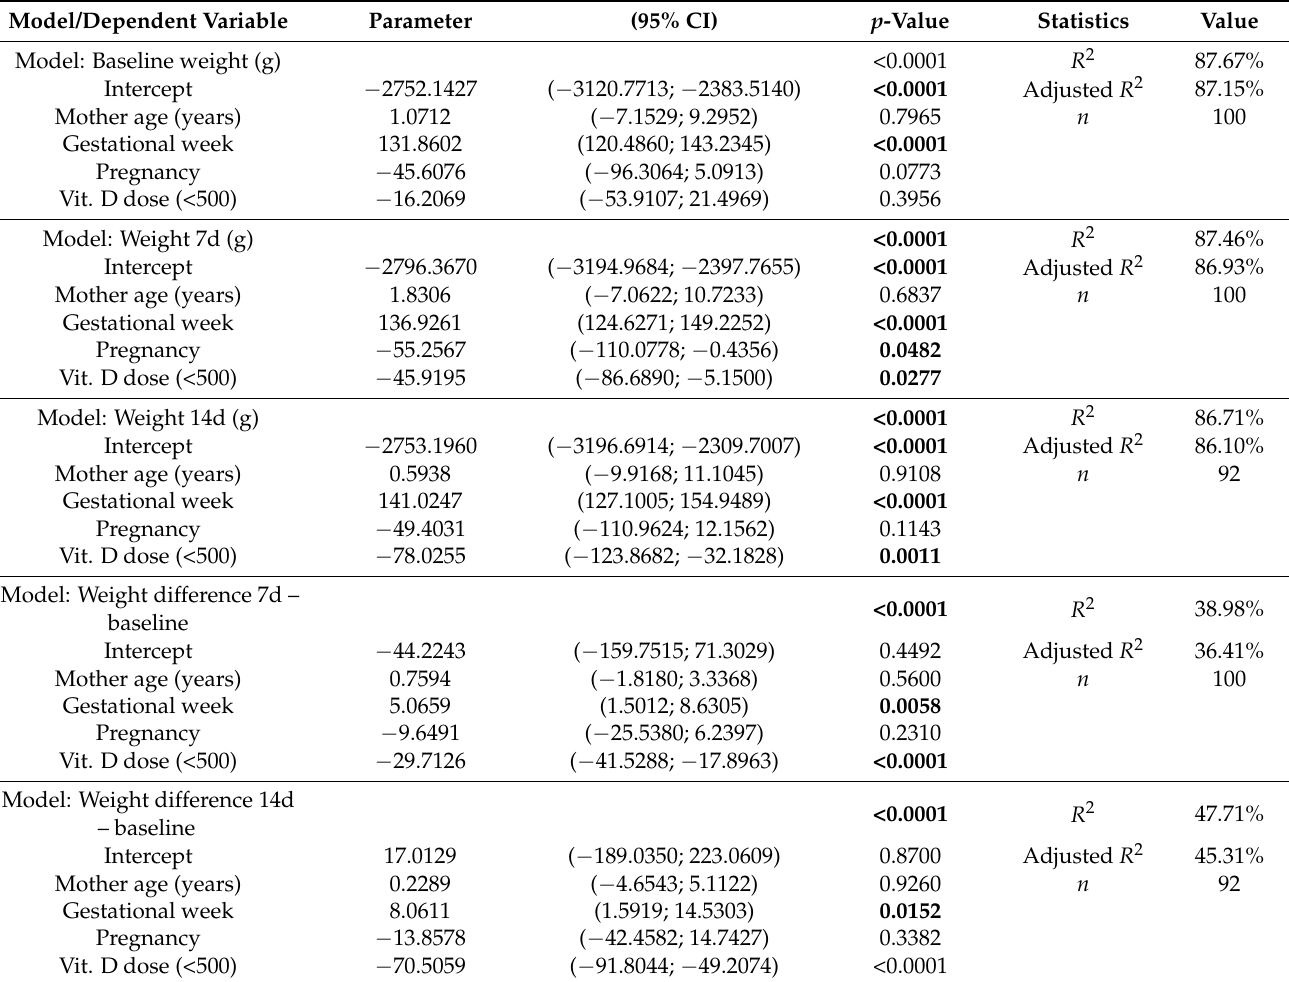
Table 2. Summary of the results of the linear regression explaining selected fetal weight